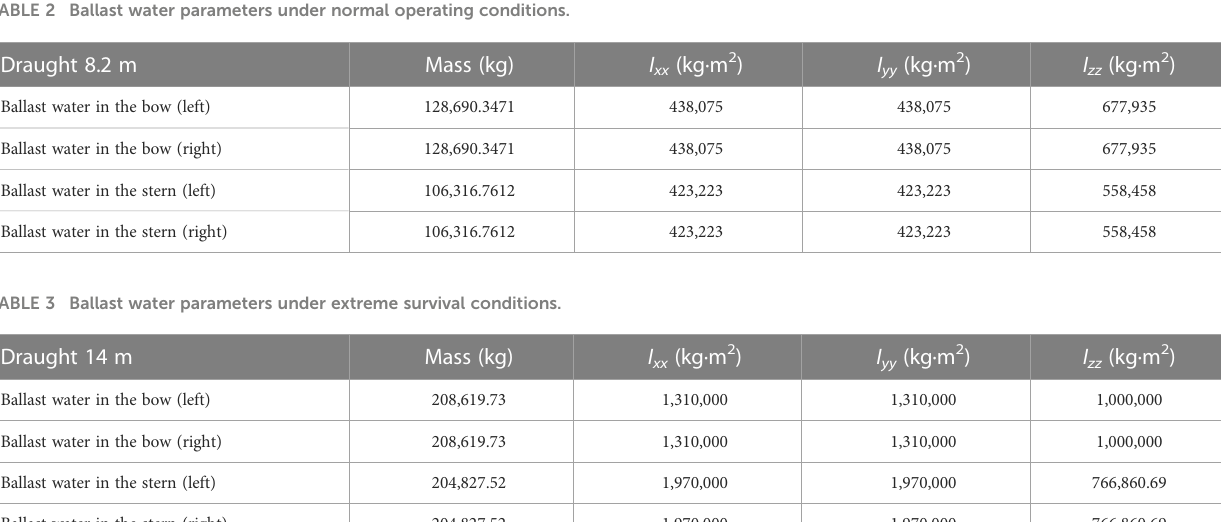
TABLE 2 Ballast water parameters under normal operating conditions.